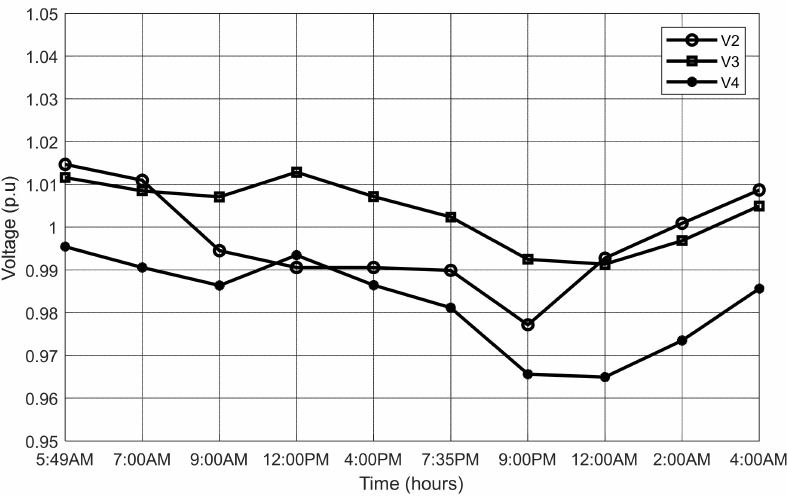
Figure 8. Voltage profiles of the three bus voltages after ANN